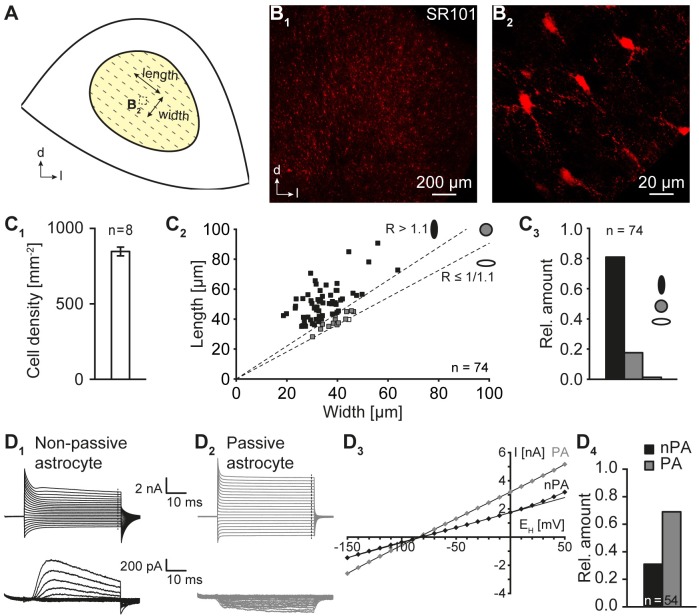
Morphological and electrophysiological properties of IC astrocytes. (A) Scheme depicting the central part of the inferior colliculus. The orientation of “length” and “width” is indicated. The dotted box denotes the location in which the astrocyte topography was subsequently analyzed. The tonotopic organization is indicated by dotted lines. (B) SR101-labeling of astrocytes in acute auditory brainstem slices. In the center of the IC strongly SR101-labeled astrocytes were found (B1) that exhibited a small soma with a diameter of about 10–15 μm (B2). (B1,2) are independent from each other. (C) Astrocyte density and morphological properties. Astrocyte density was moderate. Numbers were corrected by 38% to allow the comparison with data from PFA fixed tissue (C1; see Section “Materials and Methods”). Processes of IC astrocytes were primarily oriented orthogonal to the tonotopic axis resulting in an elevated length/width ratio (C2). Thus, most IC astrocytes exhibited an oval shape orthogonal to the tonotopic axis (C3). Length: orthogonal to tonotopic axis. Width: longitudinal to tonotopic axis [see (A)]. (D) Electrophysiological properties of IC astrocytes. Astrocytes were voltage-clamped and step-wise hyper- and depolarized (D1,2). Membrane currents were recorded before (top) and after isolation of voltage-activated outward currents (p/4, bottom). Non-passive astrocytes (nPA) expressed time- and voltage-dependent outward currents (D1). Passive astrocytes (PA) lacked voltage-dependent outward currents (D2). The I-V relationship was determined at the end of the voltage steps [dashed lines in (D1,2)]. Due to the presence of outward currents, nPAs exhibited a non-linear and PAs a linear I-V relationship (D3; see Section “Materials and Methods”). At P10-12, two third of IC astrocytes exhibited a non-linear I-V relationship (D4). n represents the numbers of analyzed slices/cells and is provided within the diagram. Shown are mean values ± SEM.